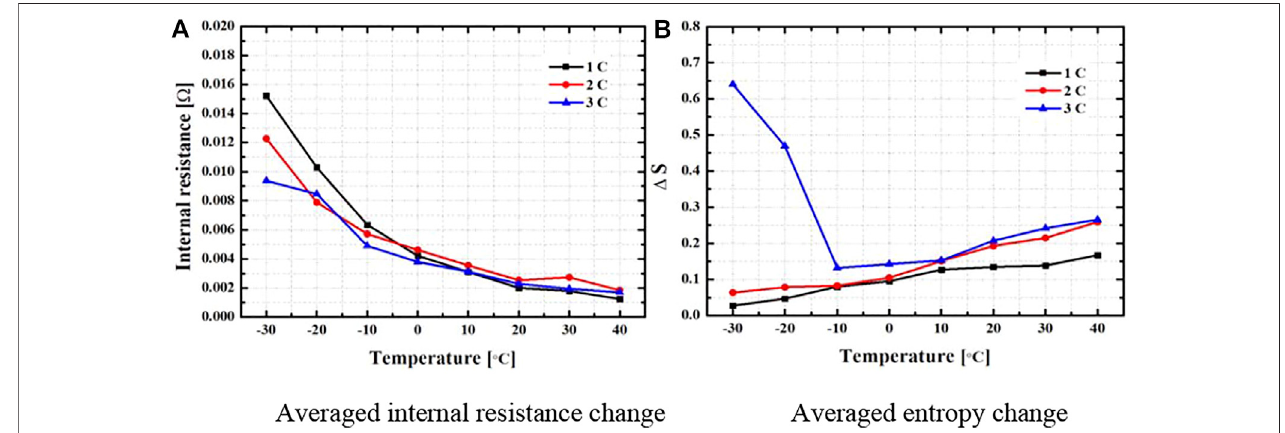
FIGURE 4 | Averaged internal resistance and entropy change on the battery. (A) Averaged internal resistance change. (B) Averaged entropy change.